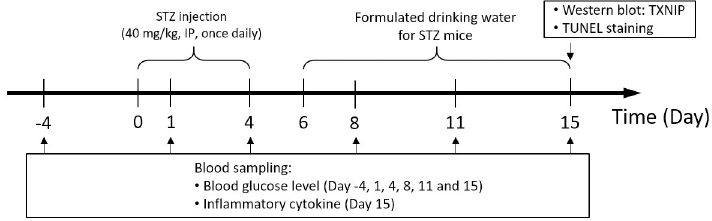
Fig 1. Scheme of STZ-induced T1DM mice administered racemic verapamil or R-Vera.